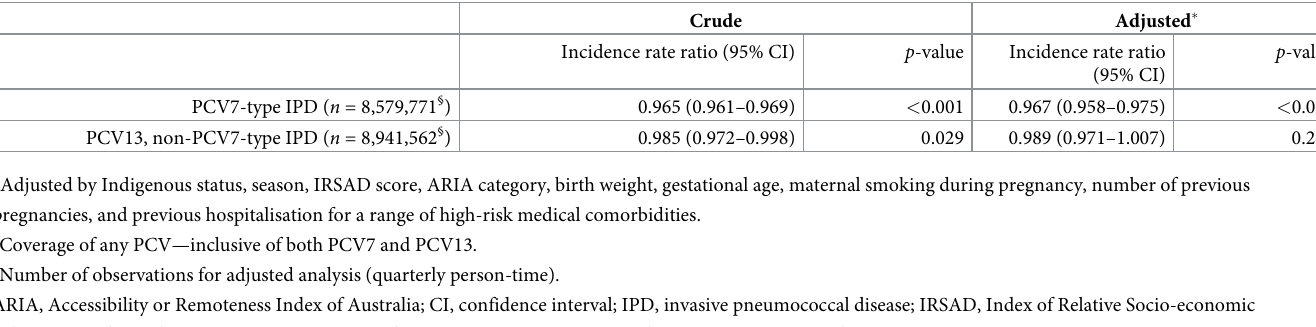
Table 4. Crude and adjusted � incidence rate ratios of PCV7-type IPD among undervaccinated children under 5 years, by percent increase in PCV coverage † among children under 5 years of age, New South Wales and Western Australia, 2009–2012.